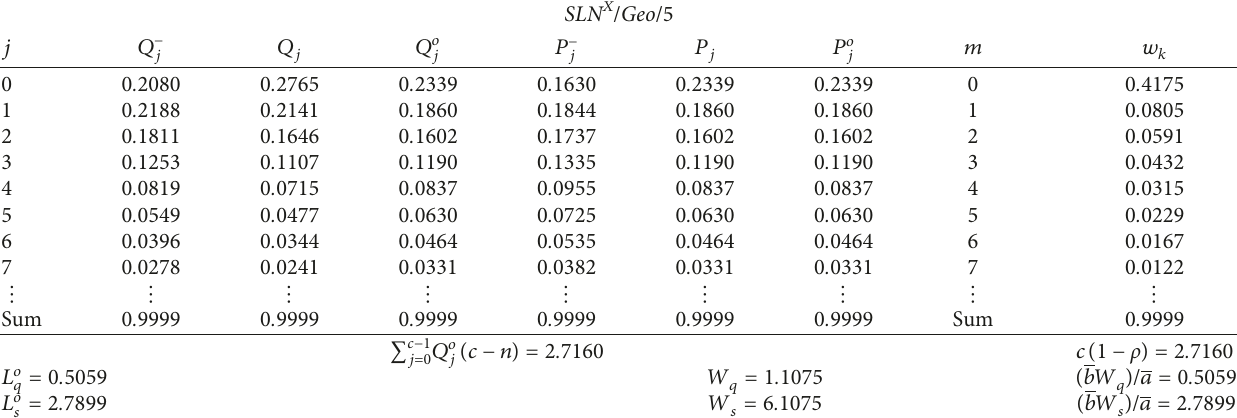
e (− [ ln ( j )] 2 ) /2 Parameters taken are b j � 1